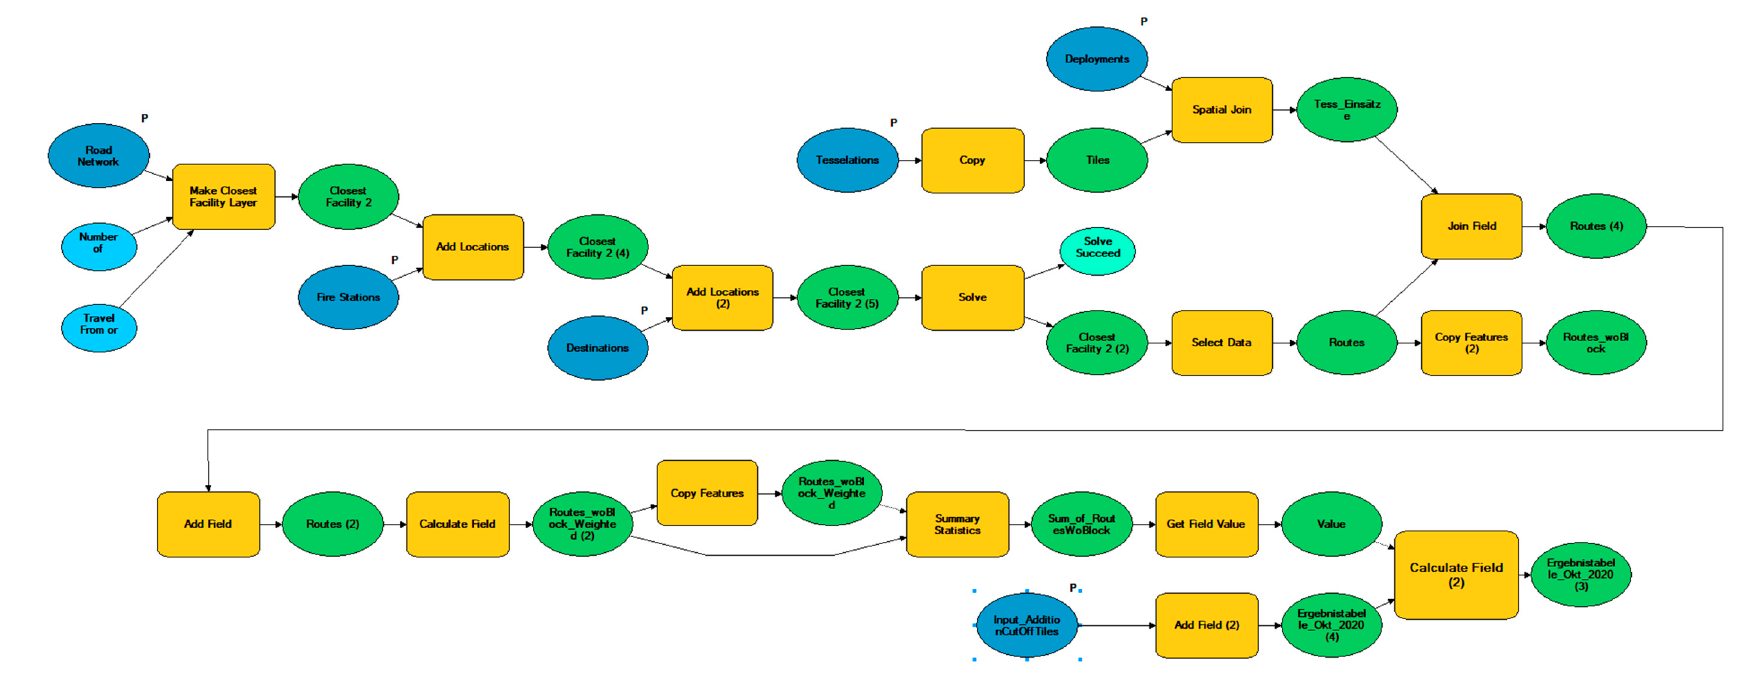
Figure A8. Di ff erence calculation level in ArcMap Figure A8. Difference calculation level in ArcMap ModelBuild.